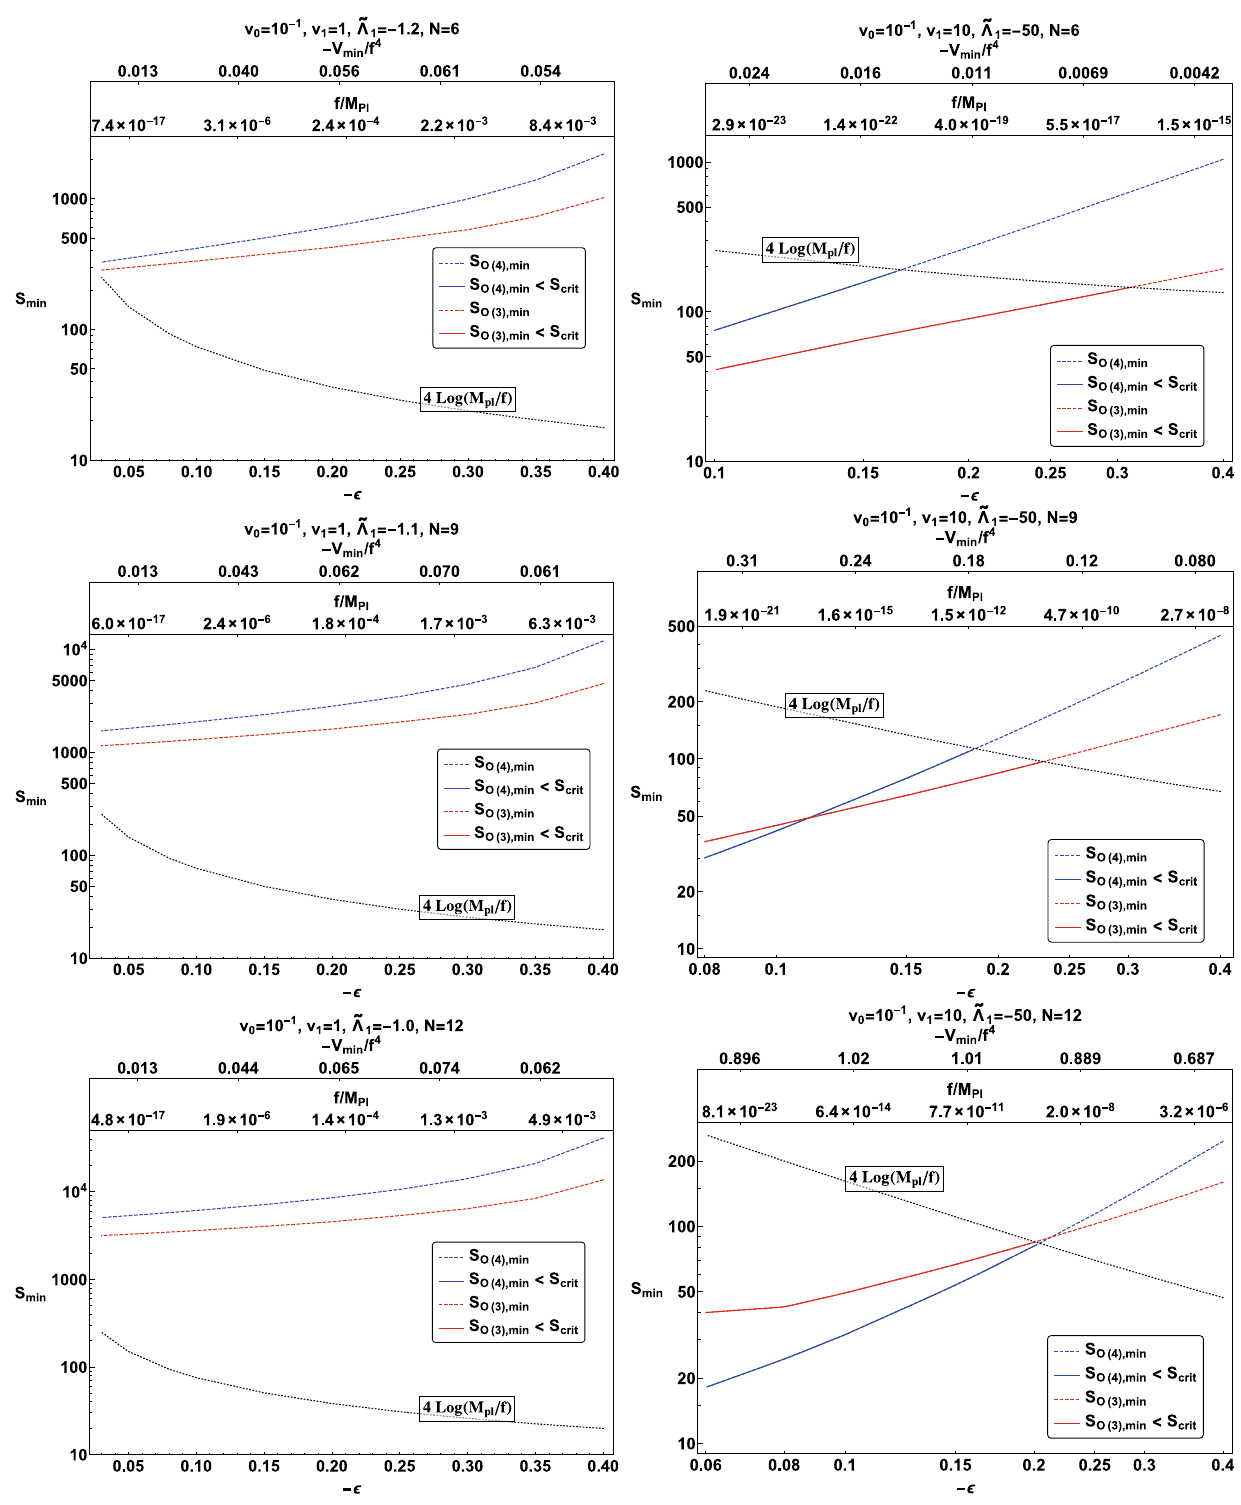
Fig. 6 In this figure, we show the value of the O ( 3 ) (red) and O ( 4 ) (blue) bubble actions for various values of the bulk scalar mass parameter, (cid:11) . Again, a comparison is made with a smaller value of v 1 = 1 (plots on the left side) vs. larger values v 1 = 10 (plots on the right